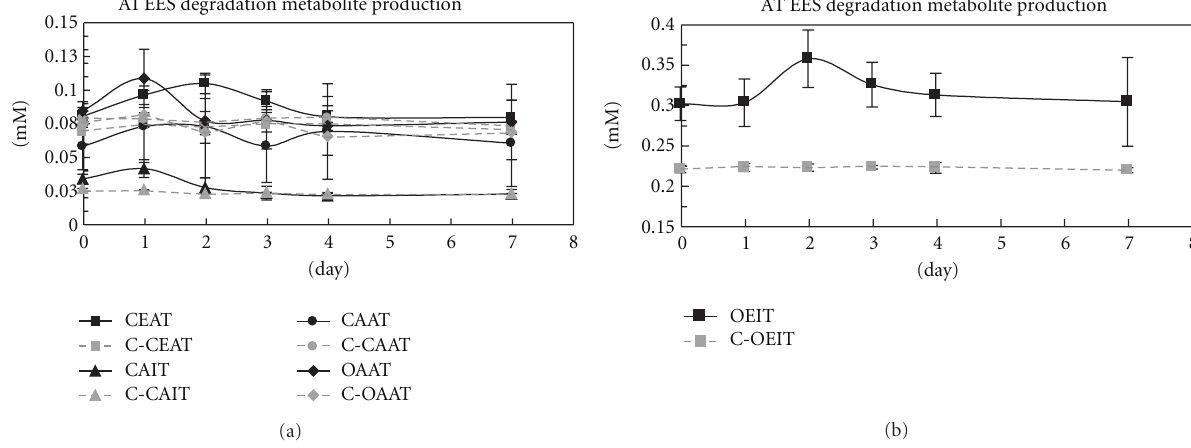
Figure 6: Production of atrazine metabolites over time in the EES degradation study. Metabolites found in control biometers (C-metabolite) are indicated by corresponding dotted lines. (a) All metabolites detected except for OEIT. (b) Hydroxyatrazine detected in biometer flasks. Numbers are the average of 9 values. Error bars represent one standard deviation of triplicate